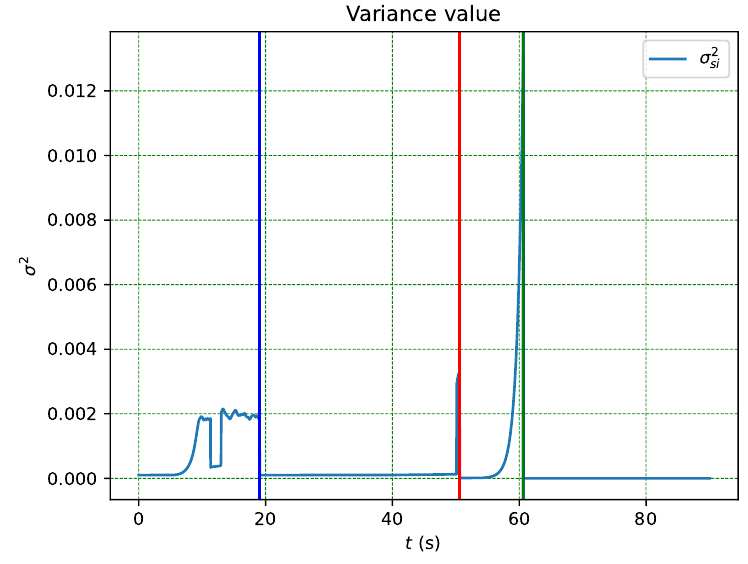
Figure 16. Variance given in each phase.